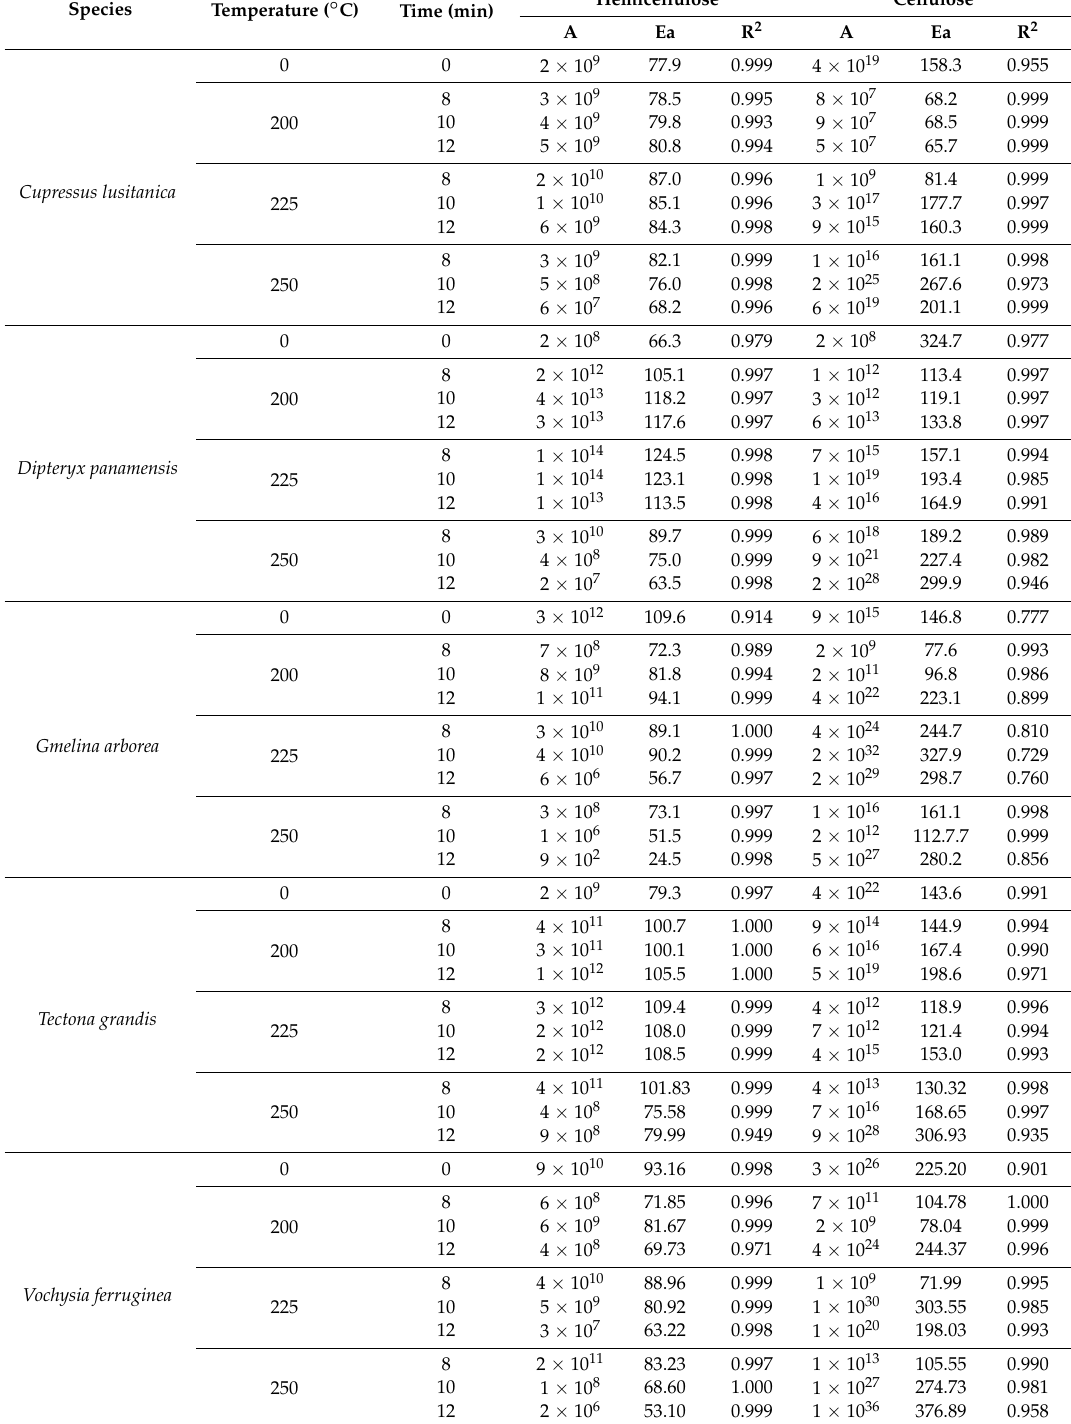
Table 4. Activation energies and pre-exponential factors for the thermal decomposition of hemicellulose and cellulose observed in biomasses of five fast-growth plantation species in Costa Rica torrefied at different times and